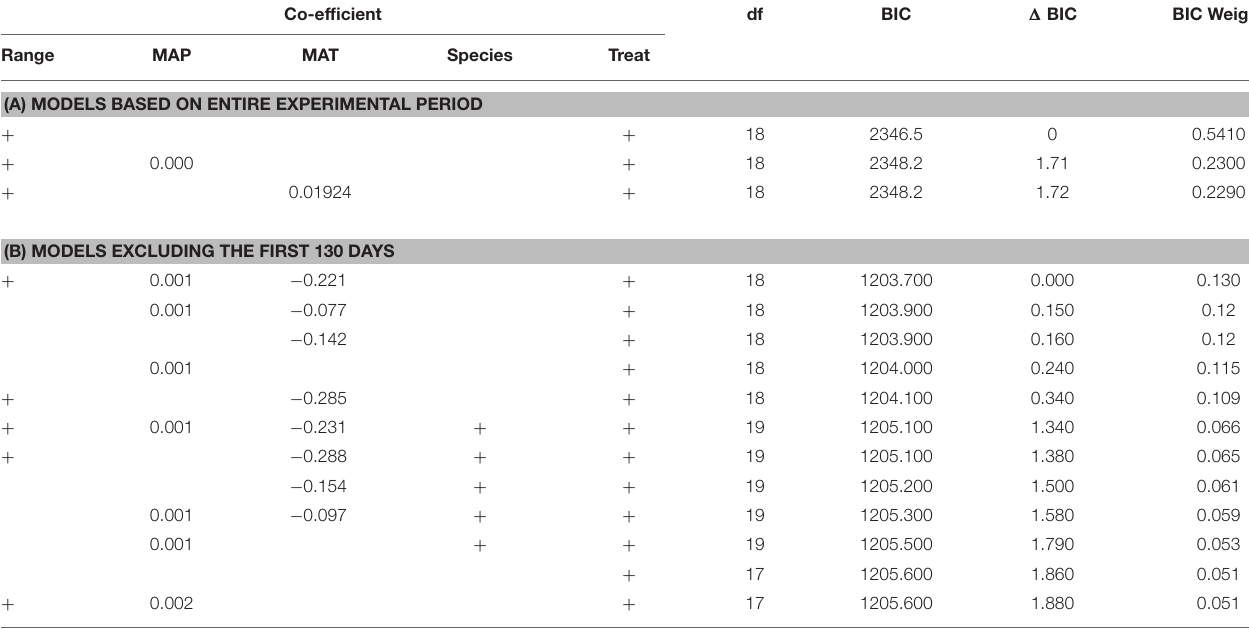
TABLE 2 | Best models (where BIC < 2) assessing the relationship between variables and seedling survival for (A) the entire experimental period and (B) the entire experimental period but with the first 130 days receiving a lower weighting (Alpha = − 10). Co-efficient df BIC 1 BIC BIC Weight Range